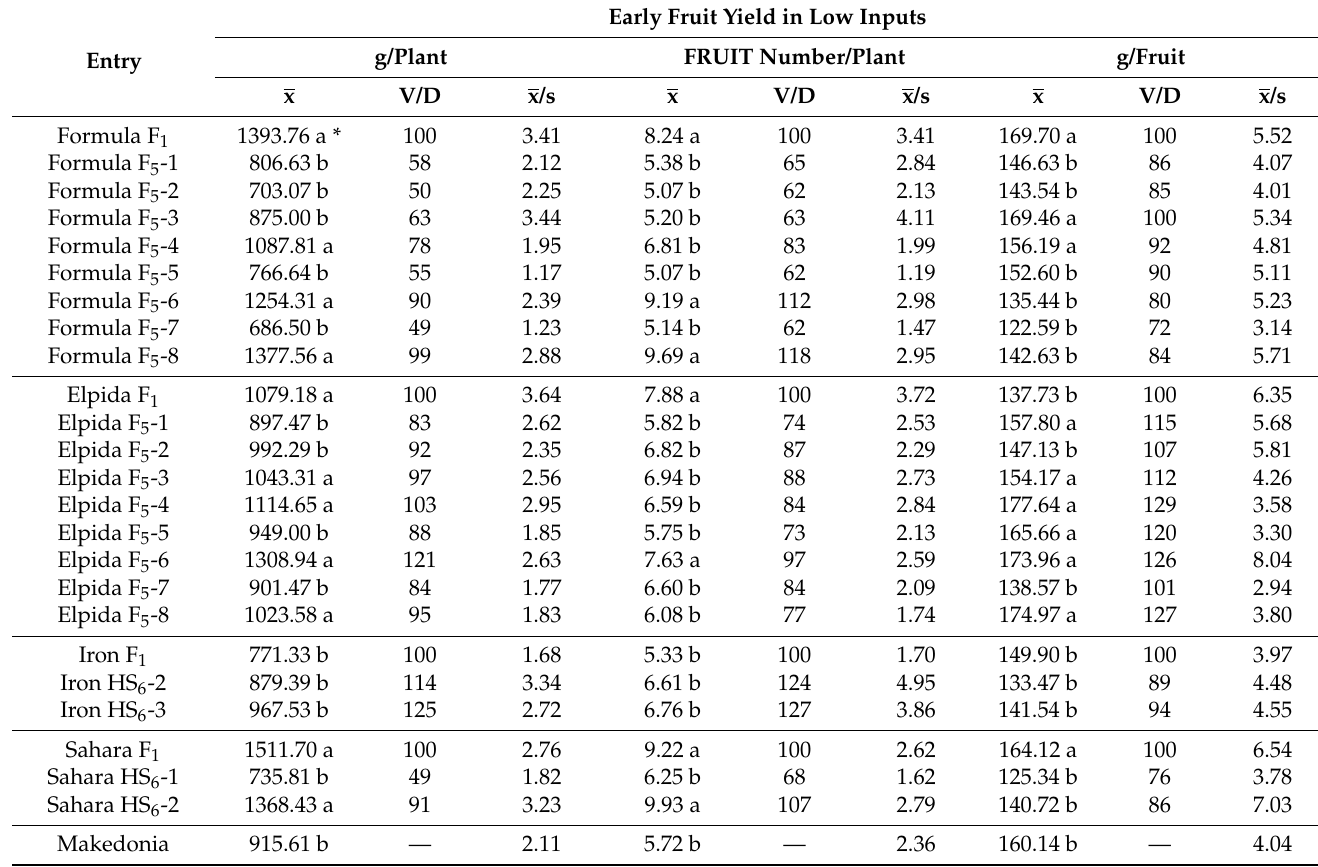
Table 3. Early fruit yield (g/plant, fruit number/plant, and g/fruit), vigor/depression (% of its corresponding hybrid), and stability of performance ( x /s) of the hybrids and new recombinant inbred lines, in the low-input farming